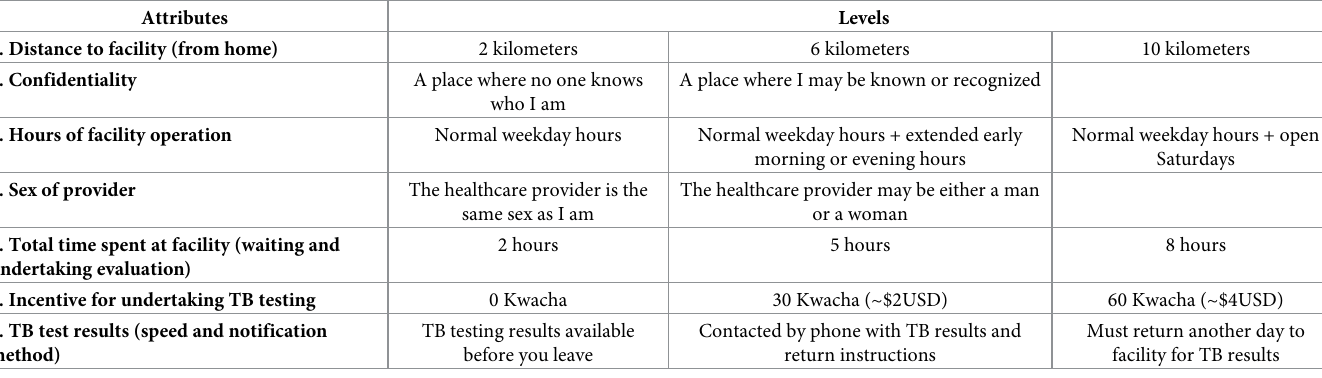
Table 1. Discrete choice experiment attributes and attribute levels to evaluate patient preferences for improving tuberculosis services in Zambia.